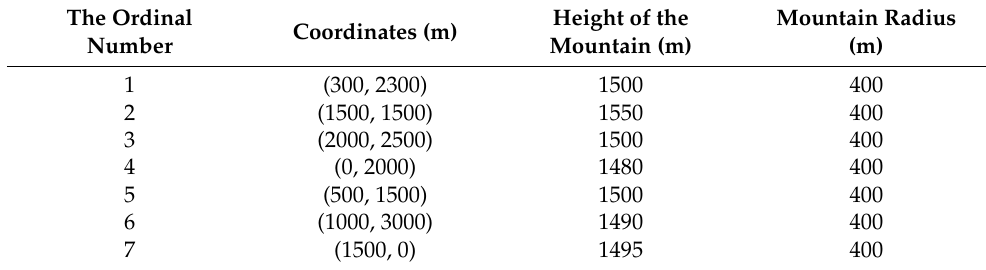
Table 2. Mountain model